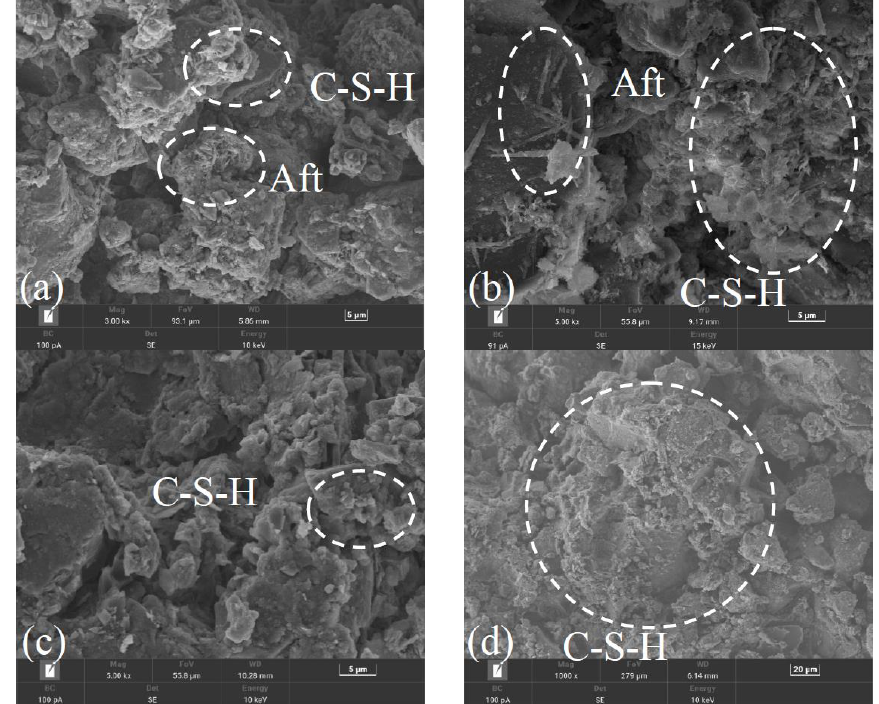
Figure 11. SEM pattern of ISW-improved silt with ( a ) curing age of 7 days and ( b ) curing age of 28 days, cement-improved silt with ( c ) curing age of 7 days and ( d ) curing age of 28